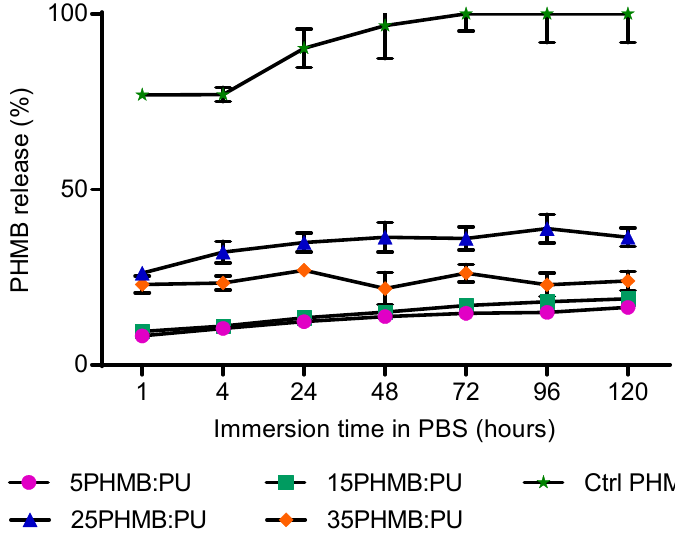
Figure 6. Average percentage release of PHMB from electrospun PHMB:PU membranes after immersion in PBS. Error bars describe the standard deviation from the mean, with n = 3. Paper disks freely infused with PHMB (Ctrl PHMB) were used as controls, as described in the methods section.